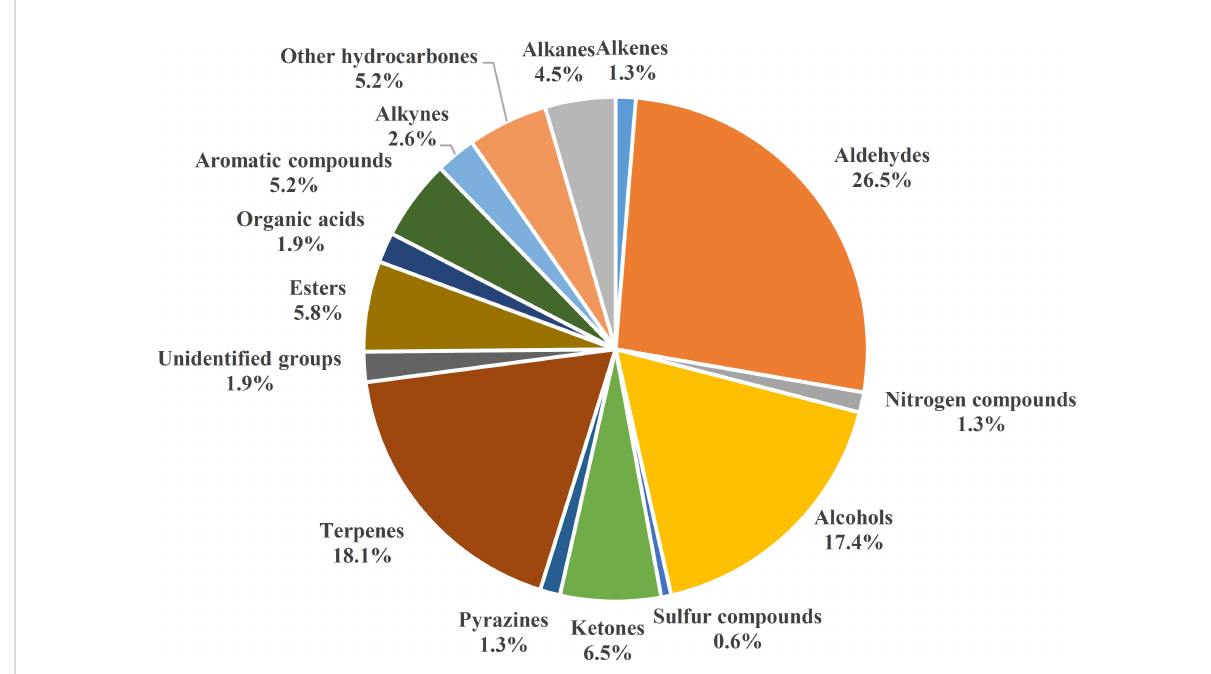
FIGURE 1 Diversity of plant root VOCs, 155 volatile compounds from different plants collected from 2016 to